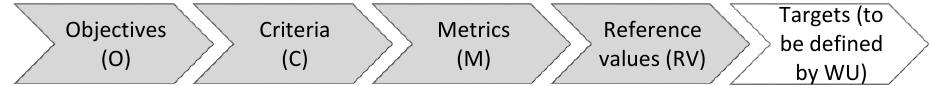
Figure 1. Structure of the PAS.